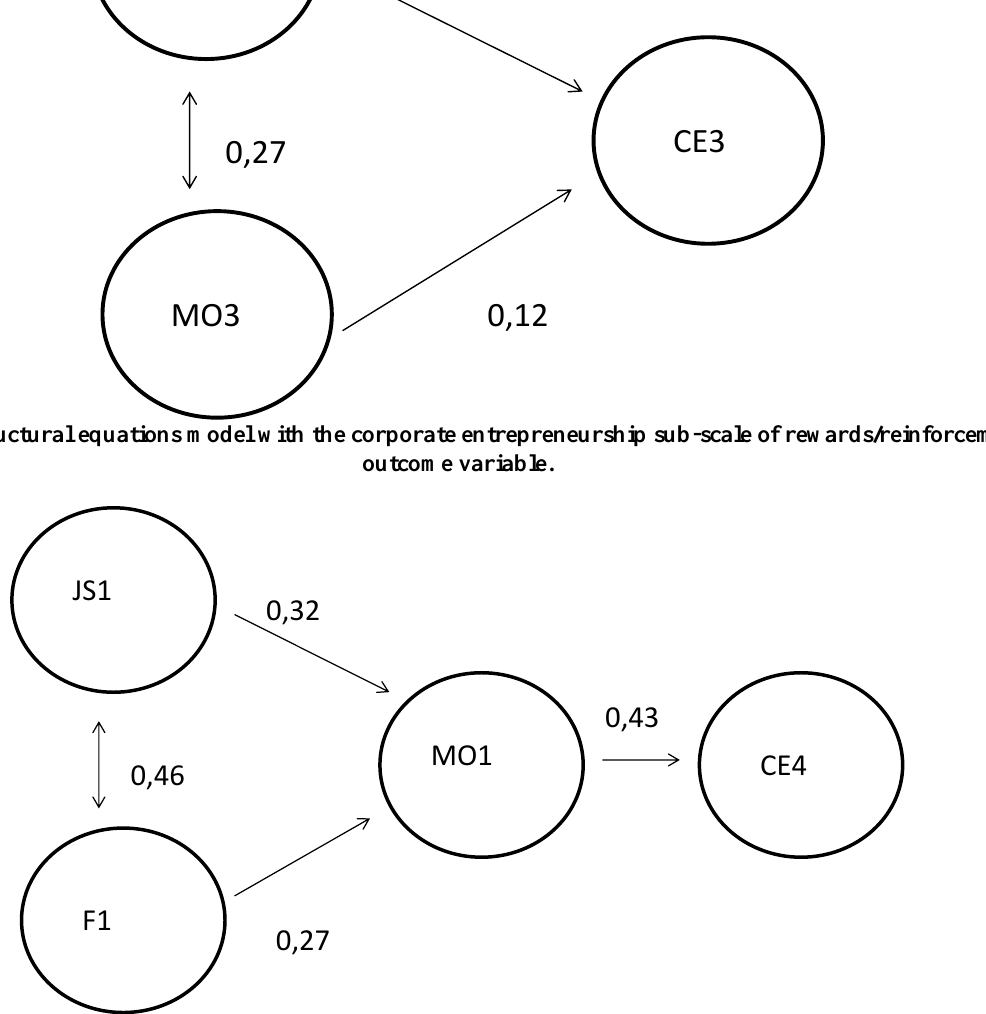
Figure 5: Structural equations model with the corporate entrepreneurship sub-scale of innovative initiatives as outcome